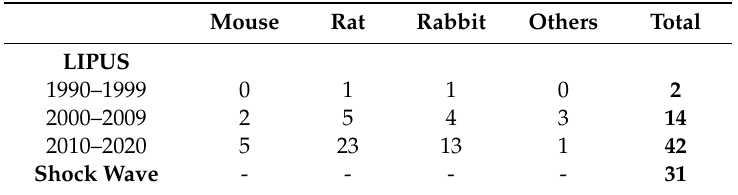
Table 3. Preclinical studies carried out in di ff erent animal models for bone healing (LIPUS or shock wave treatment alone, or combined with other therapies, e.g., mesenchymal stem / stromal cell (MSC), grafts or chemical compounds).